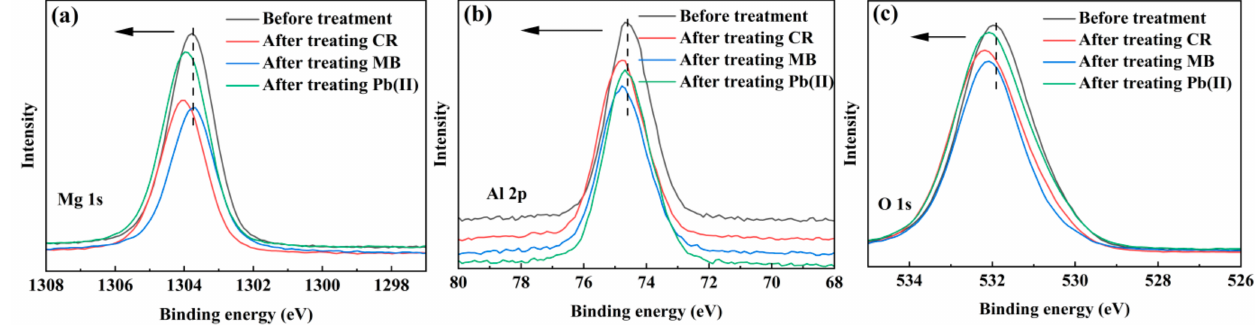
Figure 8. The high-resolution Mg 1s ( a ), Al 2p ( b ) and O 1s ( c ) scans of the HC–MgAlLDH nanocom- posite before and after treating CR, MB and